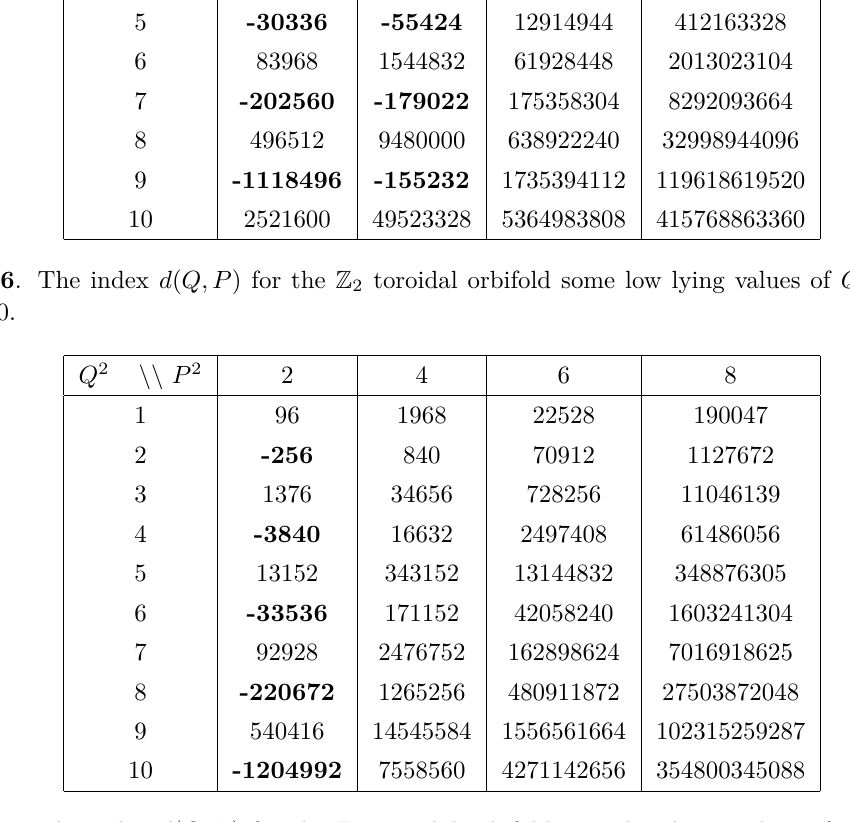
Table 17 . The index d ( Q, P ) for the Z 2 toroidal orbifold some low lying values of Q 2 , P 2 with Q · P = 1